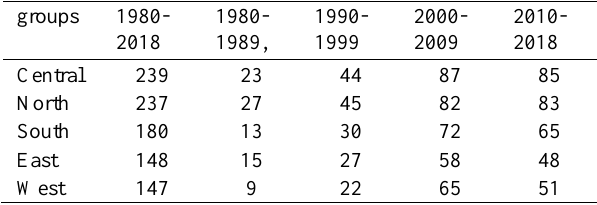
Table 2. Count months of the AOD monthly average value over